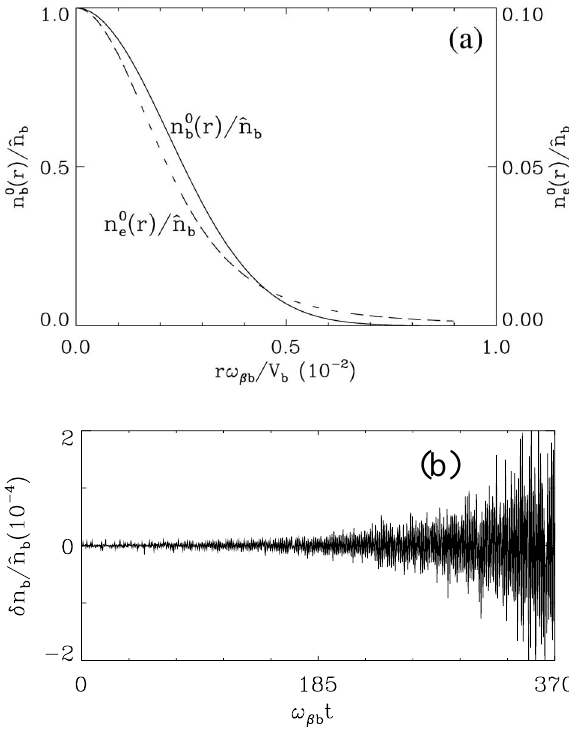
FIG. 5. Plots of (a) equilibrium proton and electron density profiles and (b) perturbation time history for cold electrons with T e (cid:1) (cid:3) T b (cid:1) (cid:1) 0.018 .